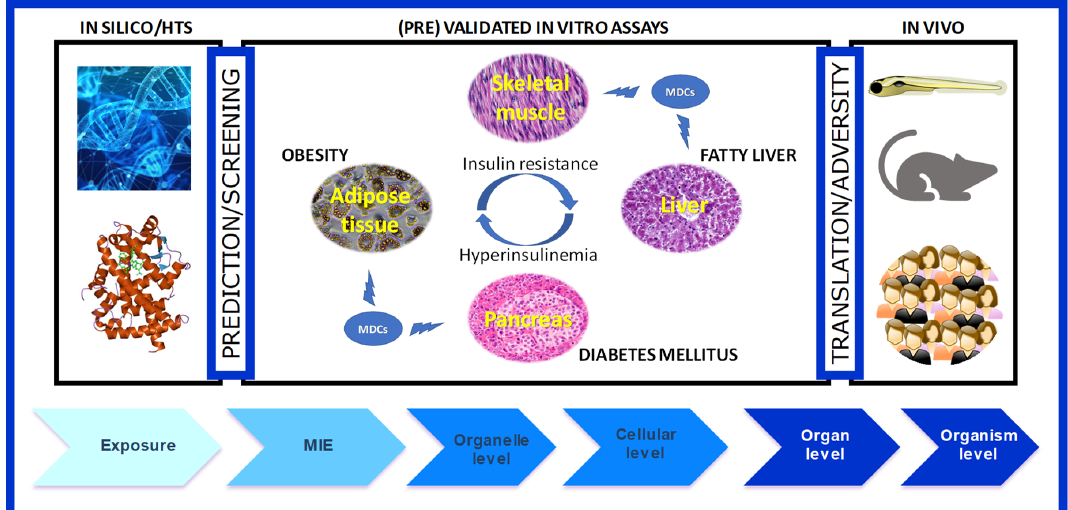
Figure 2. The schematic framework of test method development in the GOLIATH project in an Adverse